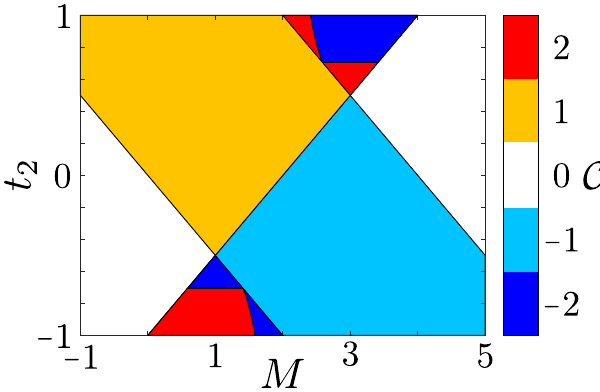
Fig. 6 Chern numbers of a defect-free system. The fi gure corresponds to the Hamiltonian in Eq. (1) with occupation probability p = 1, the mass parameter M and the second-nearest-neighbour hopping t 2 . Colour bar indicates the value of the Chern number C .